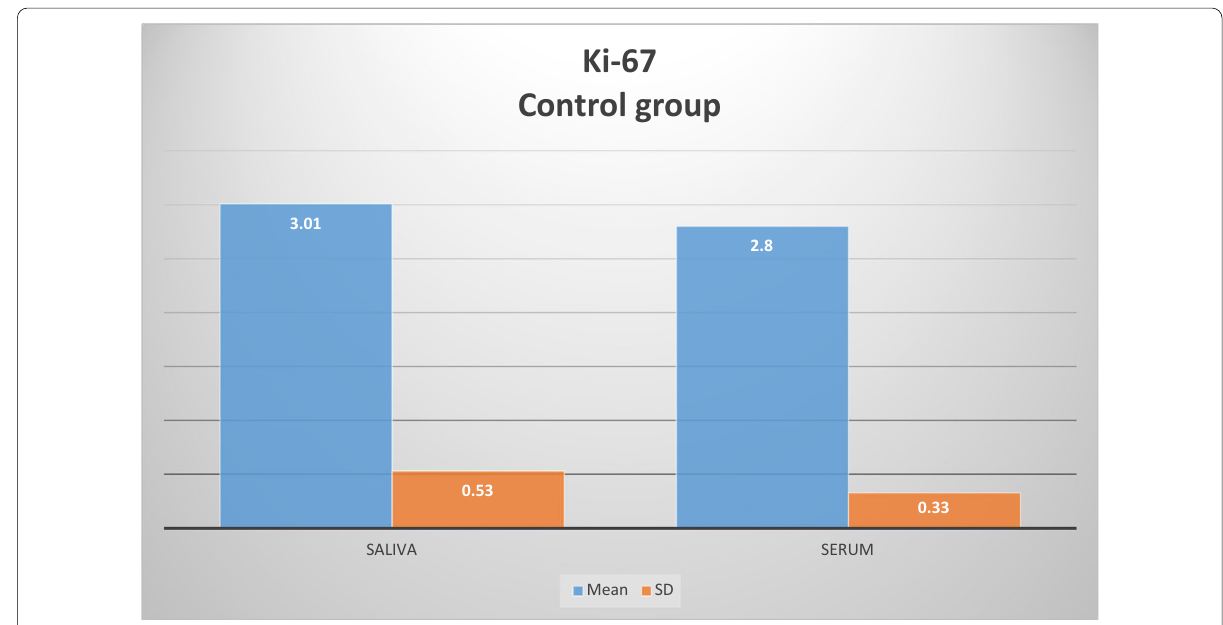
Fig. 13 Bar chart showing mean and standard deviation of Ki-67 saliva and serum in control group